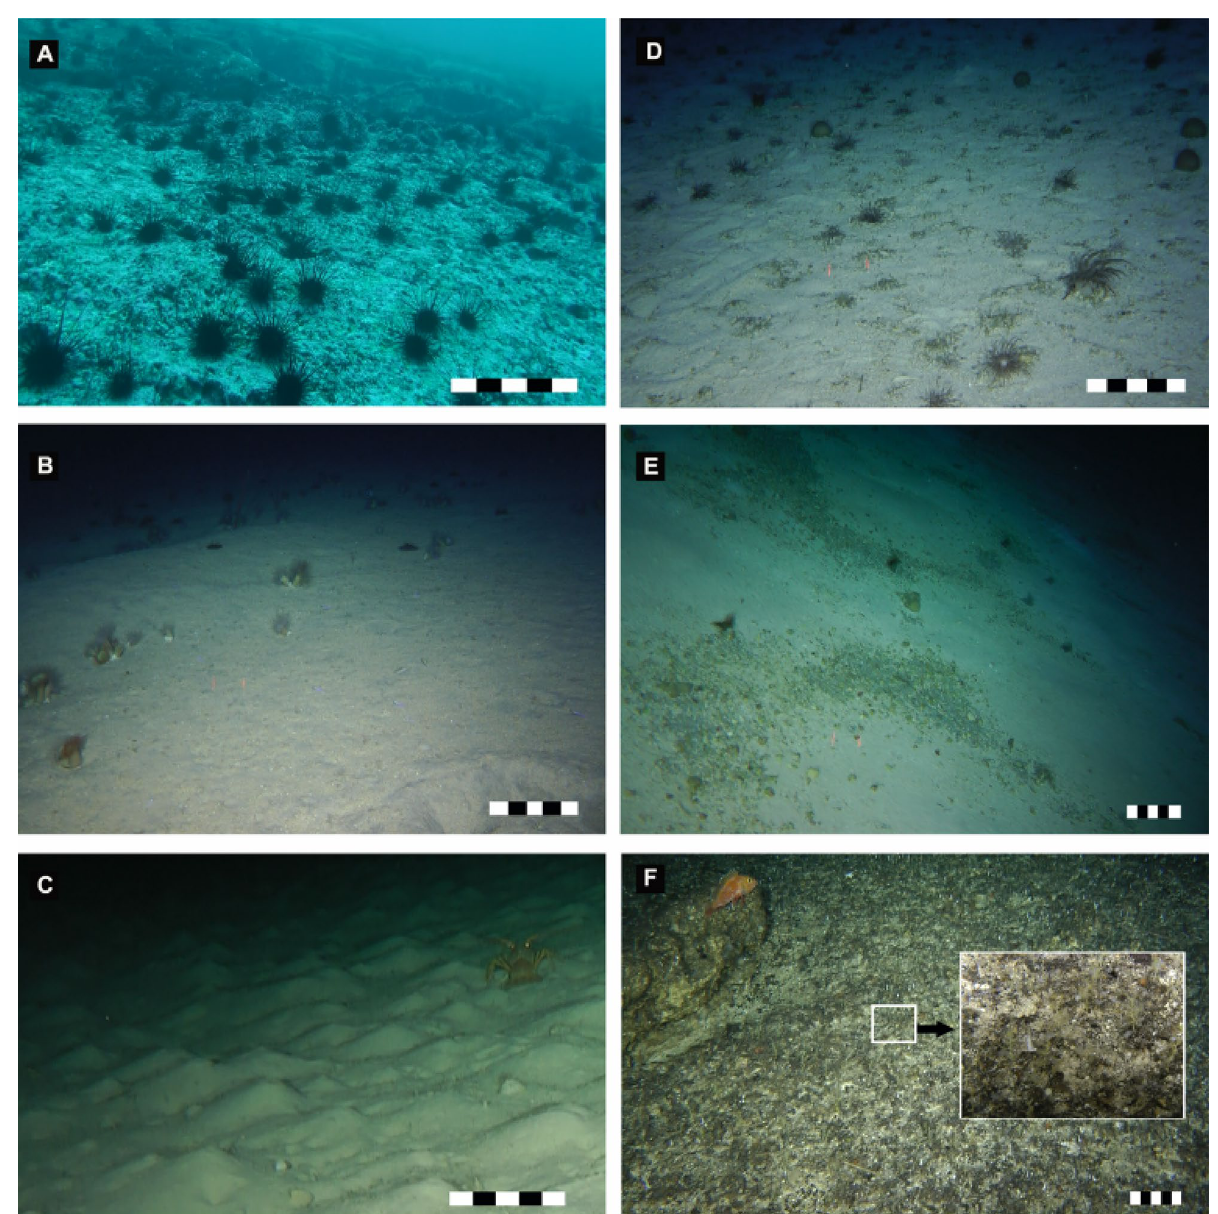
Figure 2. Benthic macrohabitats on the upper slope of Desventuradas islands ( A – C ) and summits of seamounts ( D – F ) at the Nazca-Desventuradas Marine Park. ( A ) Irregular rock bottom with fractures and faults, ( B ) regular continuous homogeneous bottom with coarse sand dominated by anemones ( Hormathia sp), ( C ) silty sediments with the presence of bioturbation ripples, ( D , E ) regular continuous homogeneous bottom with little relief, coarse sand and rhodoliths, dominated by sponges (unidentified demosponges) and anemones ( Hormathia sp. and cerianthids), ( F ) irregular rock bottom with structures fractured, faulted and folded, characterized by sea pens ( Scleroptilum sp.), hydrozoan corals ( Stylaster sp.) and some fishes ( Helicolenus lengerichi ). Scale bar: 25 cm. Image credits: